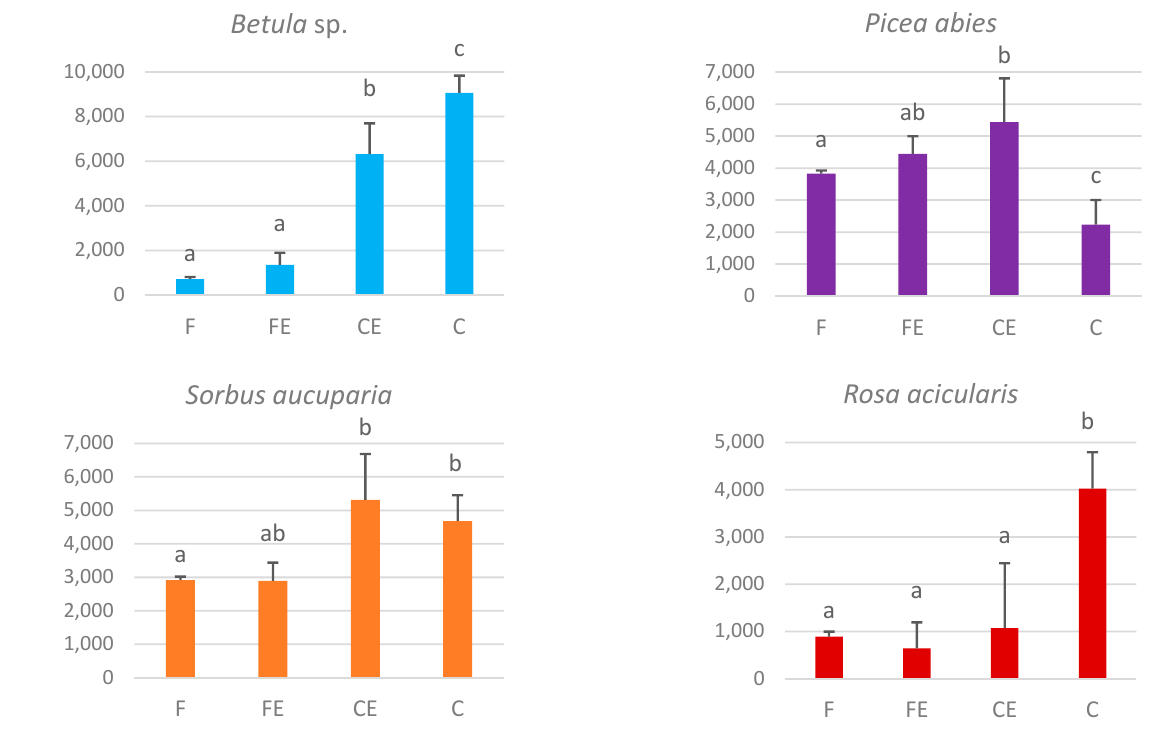
Figure 5. Average amounts of regeneration and understory in all the surveyed transects, plants/ha: birch, spruce, rowan, and prickly rose in the bilberry spruce forest—clear-cut EC (mean and standard error) for transitional zone width of 8 m in each direction from the forest edge. Legend as in Figure 2. Letters indicate differences between means (based on ANOVA results). Forests 2021 , 12 , x FOR PEER REVIEW